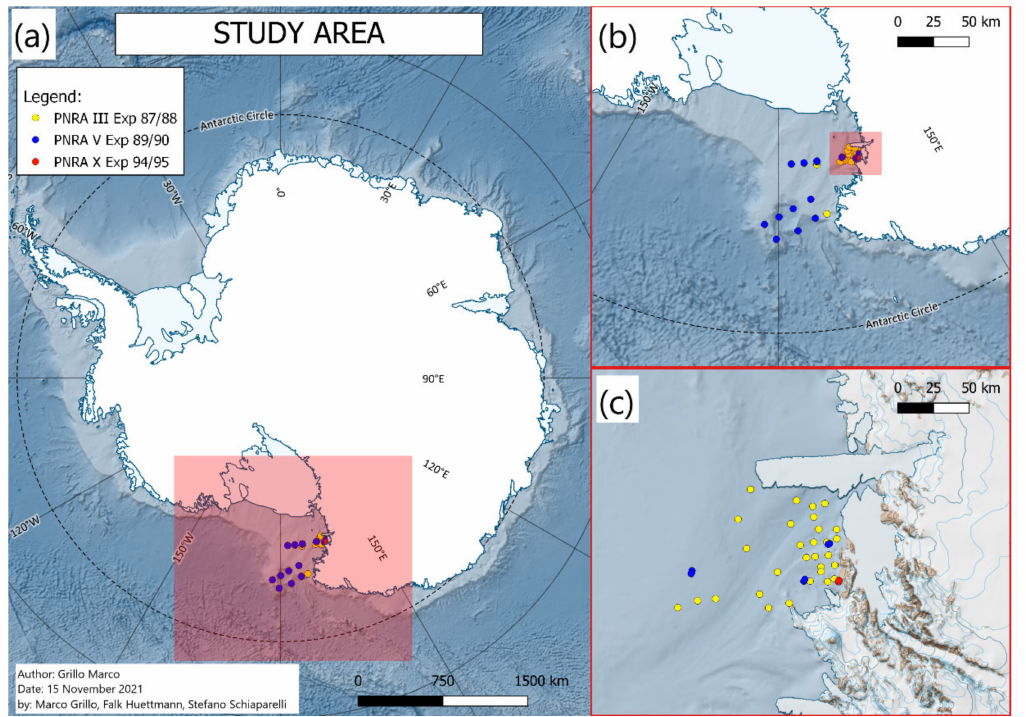
Figure 1. Study area. ( a ) Stations sampled in the Ross Sea area. ( b , c ) Stations sampled in the Terra Nova Bay